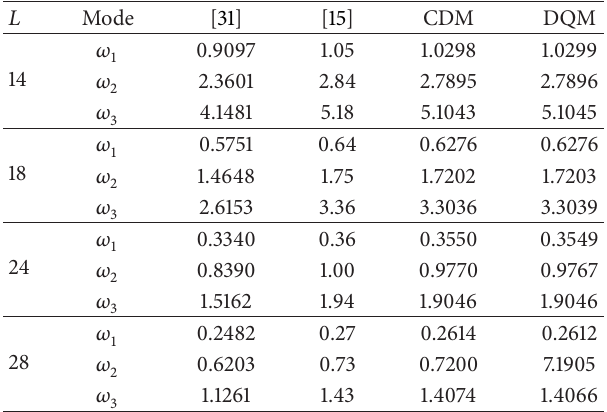
Table 10: Numerical comparison among [15, 31] CDM and DQM and the first three free frequencies of vibrations of DWCNTs are reported (for 𝜂 = 0 ).